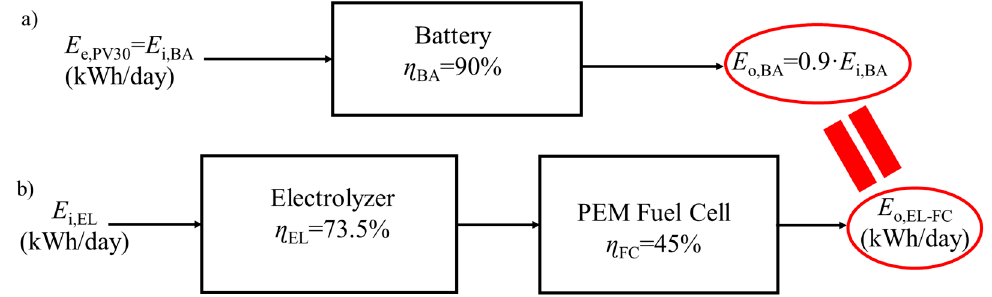
Figure 4. The energy balance of two systems: ( a ) battery system, ( b ) electrolyzer–fuel cell system.